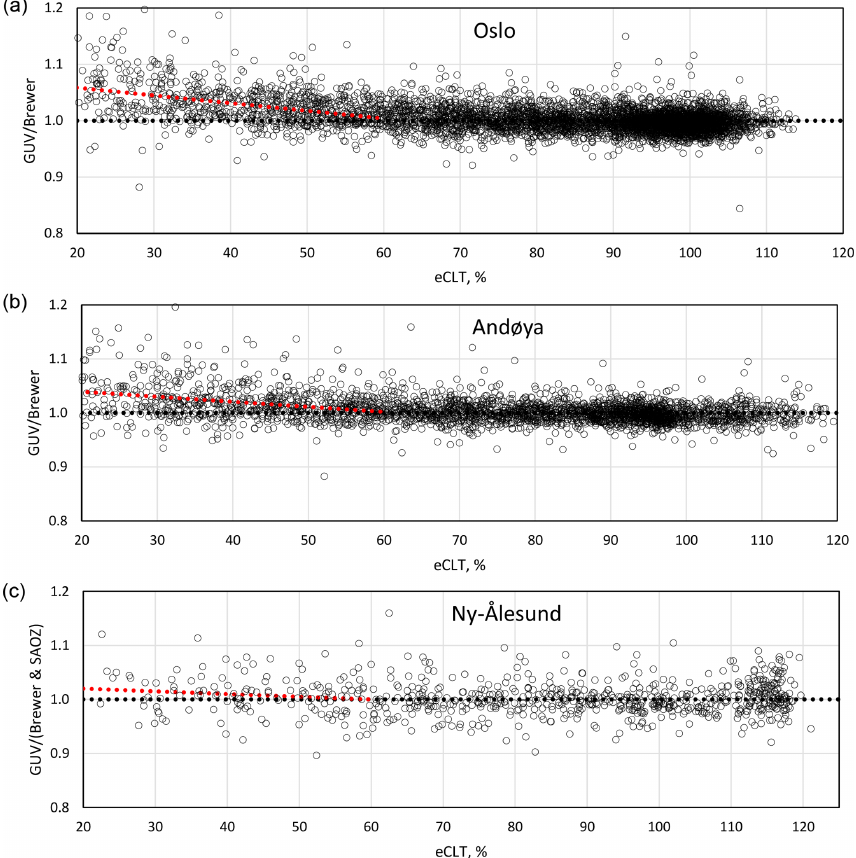
Figure 5. Ozone difference between GUV and Brewer DS (and SAOZ) as a function of eCLT: Oslo (a) , Andøya (b) , and Ny-Ålesund (c) . The red dotted lines indicate the linear best fitting for eCLT < 60%. The presence of eCLT higher than 100% is discussed in Sect. 2.3.